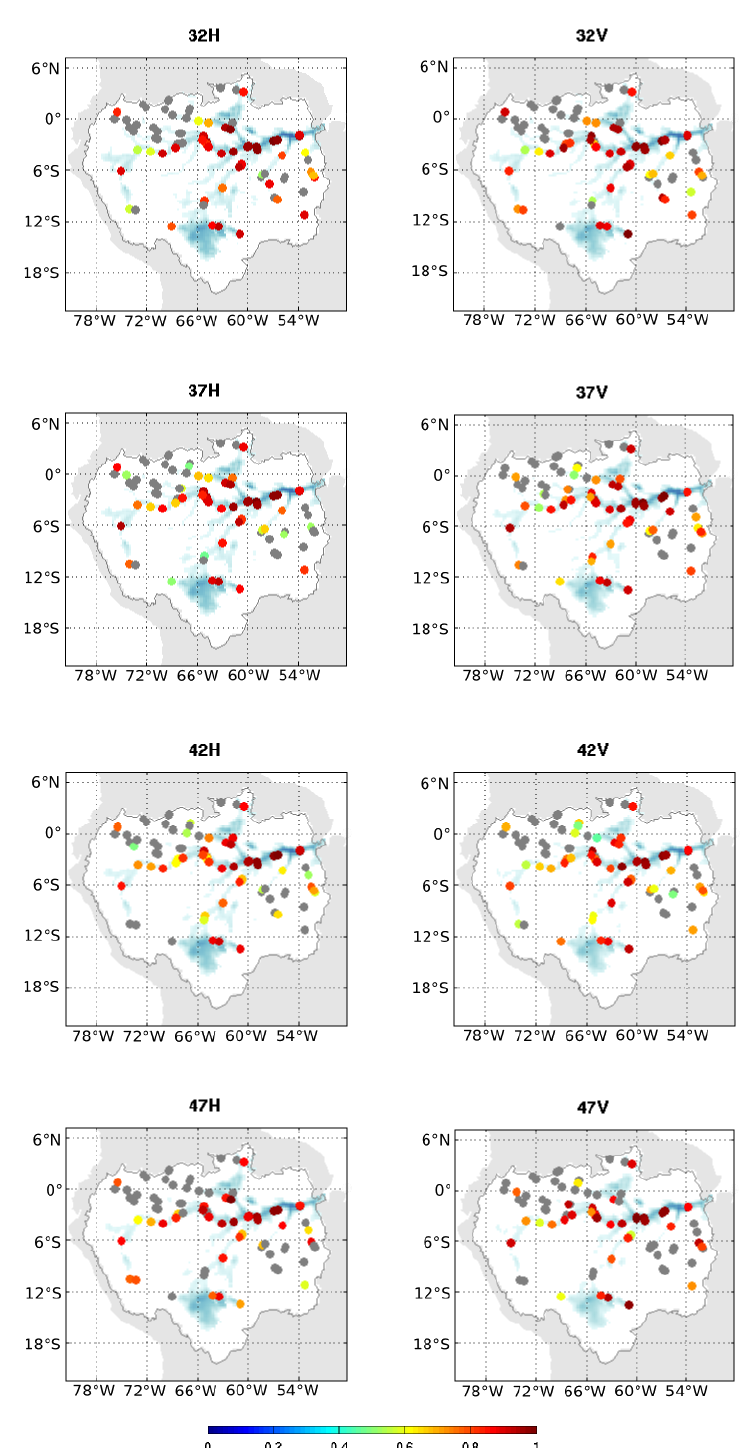
Figure 10. For each SMOS configuration, correlation values against the SWAF water surface extent and the water level measured by Jason-2 during 2010–2012. The color dot represents the correlation value. Gray color dots show no significant results ( p -value >